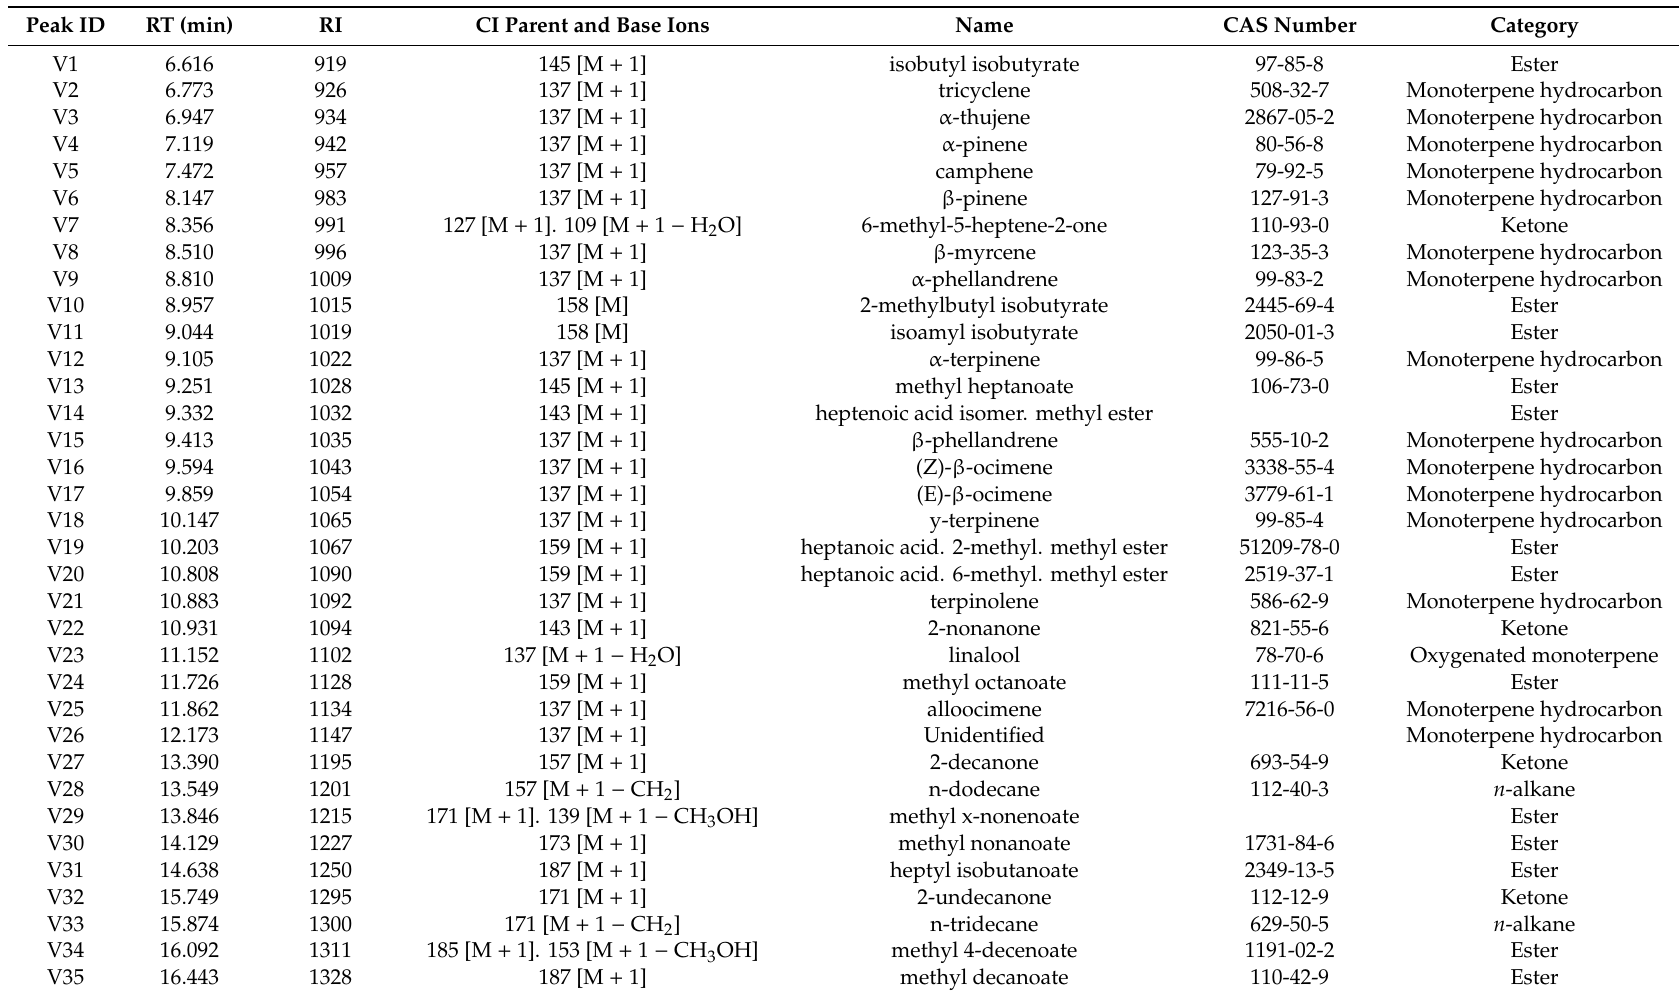
Table 3. Volatile components identified in the headspace of dried hop cones harvested from 15 varieties cultivated in the Marche region (Central